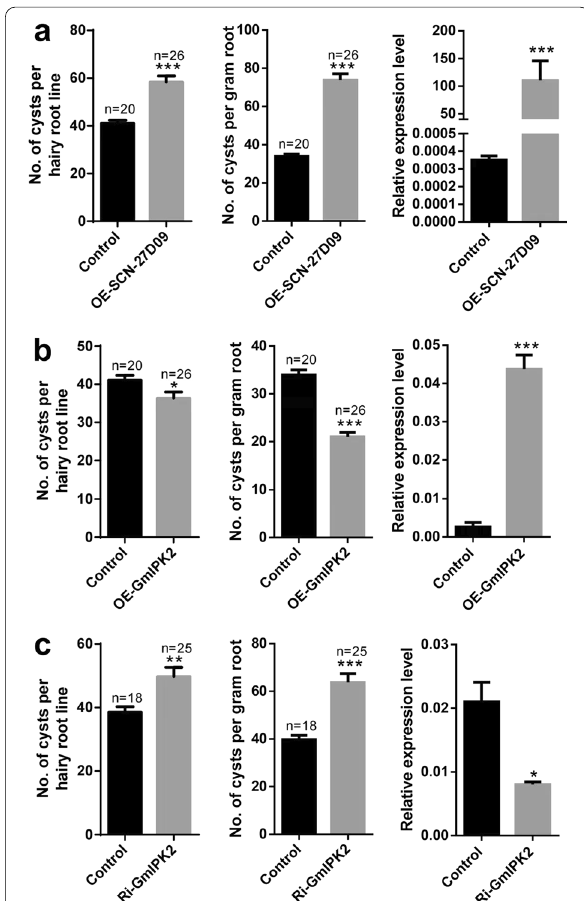
Fig. 6 GmIPK-2 plays a positive role against soybean cyst nematode. a The numbers of cysts per hairy root line (left panel) and per gram root (middle panel) in Williams 82 (control) and SCN-27D09 overexpression line (OE-SCN-27D09). Relative expression level of SCN-27D09 was shown on the right panel. b The numbers of cysts per hairy root line and per gram root in Williams 82 (control) and GmIPK-2 overexpression line (OE-GmIPK-2). Relative expression level of GmIPK-2 was shown on the right panel. c The numbers of cysts per hairy root line and per gram root in Williams 82 (control) and GmIPK-2 RNAi line (Ri-GmIPK-2). Relative expression level of GmIPK-2 was shown on the right panel. Data are means standard error. ± Significant differences were calculated by Student’s t test (* P < 0.05, ** P < 0.01, *** P <